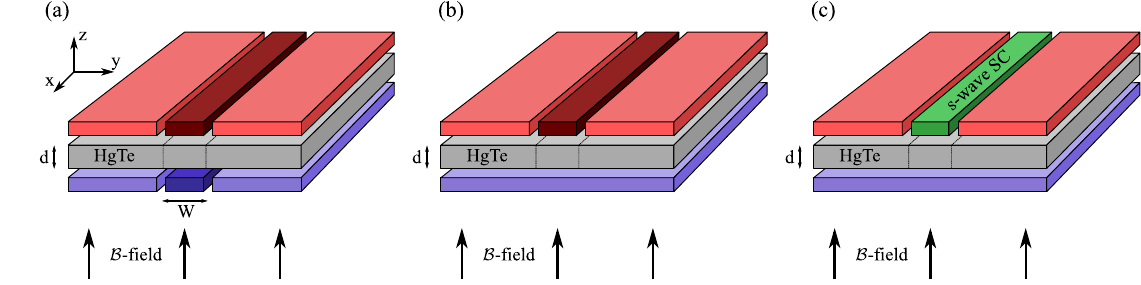
FIG. 1. Schematic experimental setups. (a) A 2D HgTe quantum well of thickness d sandwiched by top and bottom gates and impinged by a magnetic field. The outer regions are tuned into an insulating state, while the central gates define a quantum wire. Because of HgTe’s unusual band structure, properties of the quantum wire (such as Rashba coupling and Zeeman splitting generated by a perpendicular magnetic field) are exceptionally tunable. (b) Simplified experimental setup featuring a single bottom gap. In this more experimentally feasible device, parameters for the wire exhibit essentially the same level of tunability as discussed in Sec. II A 1. (c) Replacing the central top gate by a proximity coupled s -wave superconductor allows the gate-defined quantum wire to host Majorana zero modes. This application is especially attractive given the large spin-orbit energies (about 30 K) and giant effective g factors (which can reach about 600) that are